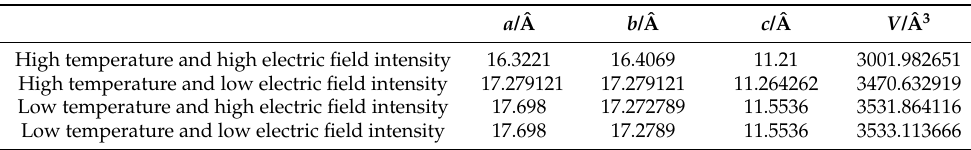
Table 3. The relationship between unit cell volume and variables. a / Â b / Â c / Â V / Â